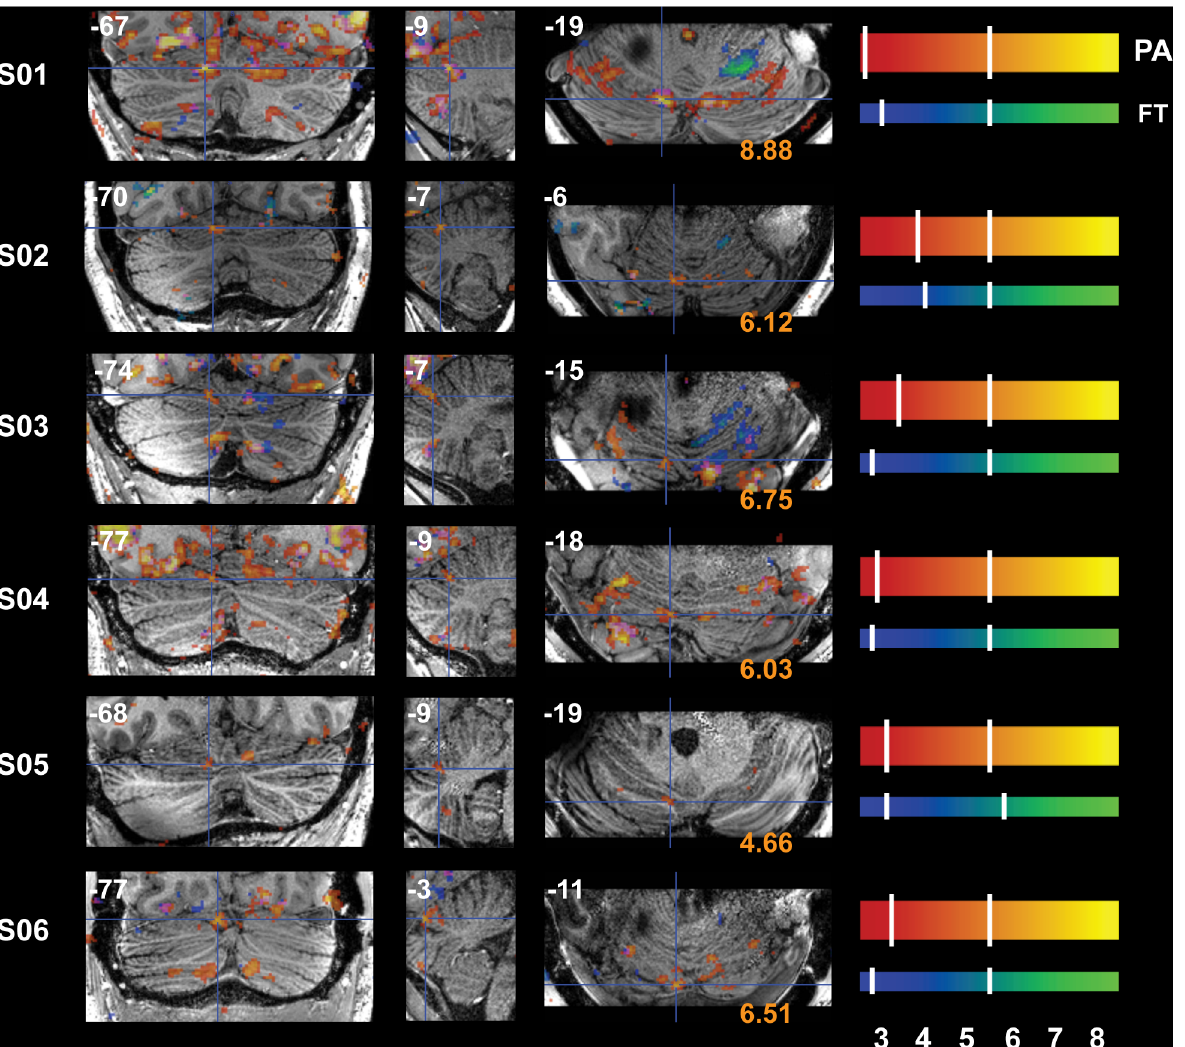
Fig 3. Functional Accuracy of Pro-Anti Activations in Cb, Bilateral VI. Bilateral h VI is activated during PA; crosshairs denote an active cluster in left paravermis VI and distinct clusters can be seen aligned along lobule VI in the axial (rightmost) panels. Slice locations (in non-normalized MNI space) are displayed at the top of each panel and T-values at the crosshairs are displayed at the bottom of the axial panels. Refer to Fig 1a for a guide to anatomical lobule